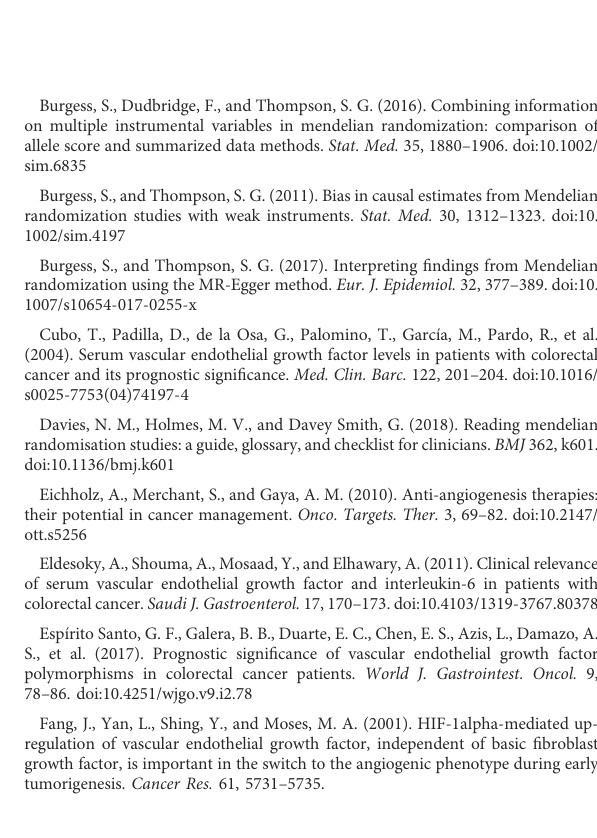
Leave-one-out inverse-variance weighted mendelian randomization- analyses of different types of cancer on circulating VEGF. ( A ) Breast cancer; ( B ) ER+ Breast cancer; ( C ) ER- Breast cancer; ( D ) Ovarian cancer; ( E ) High grade serous ovarian cancer; ( F ) Invasive